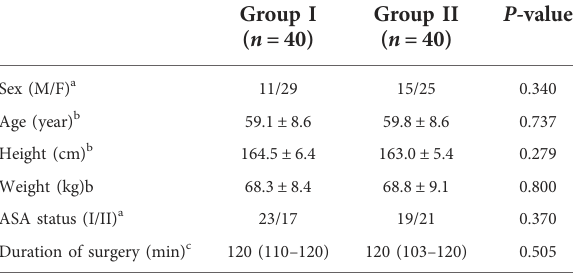
TABLE 3 Comparison of the TCI concentration of propofol and remifentanil during the maintenance of anesthesia.